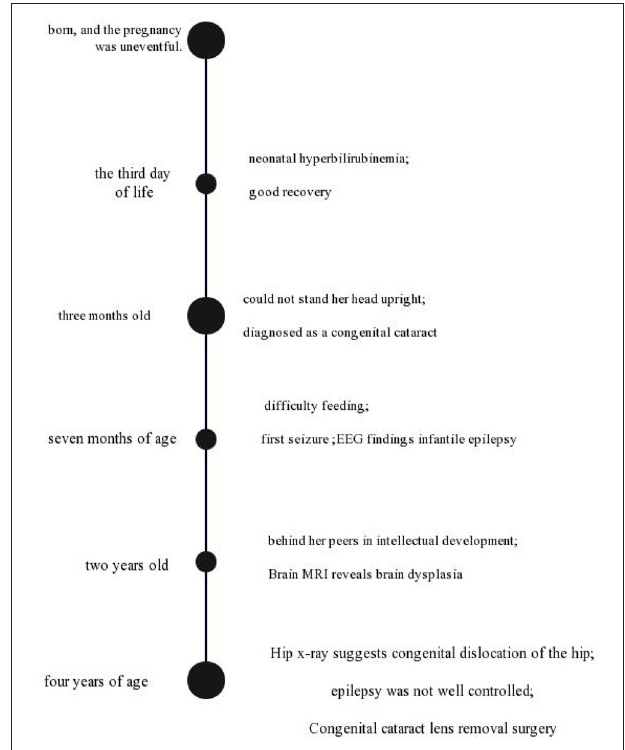
FIGURE 1 | A timeline with relevant data from the patient episode of